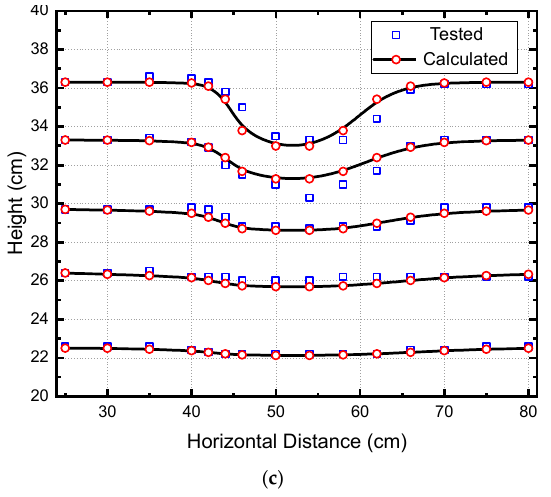
Figure 12. Comparison between the observed and corrected values at different depths in the labor- atory tests for the ( a ) T1, ( b ) T2, and ( c ) T3 energy levels.